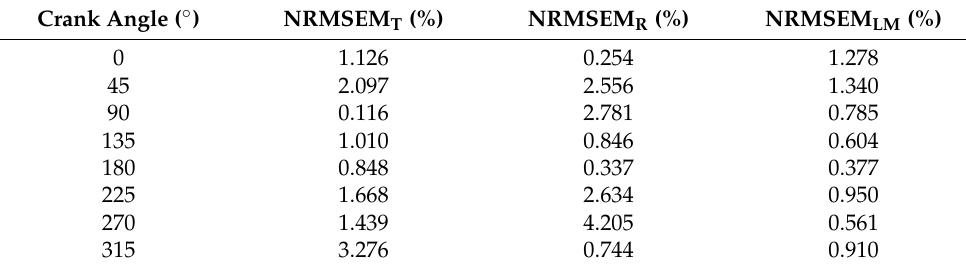
Table 6. NRMSE of F T , F R and F LM (results expressed in